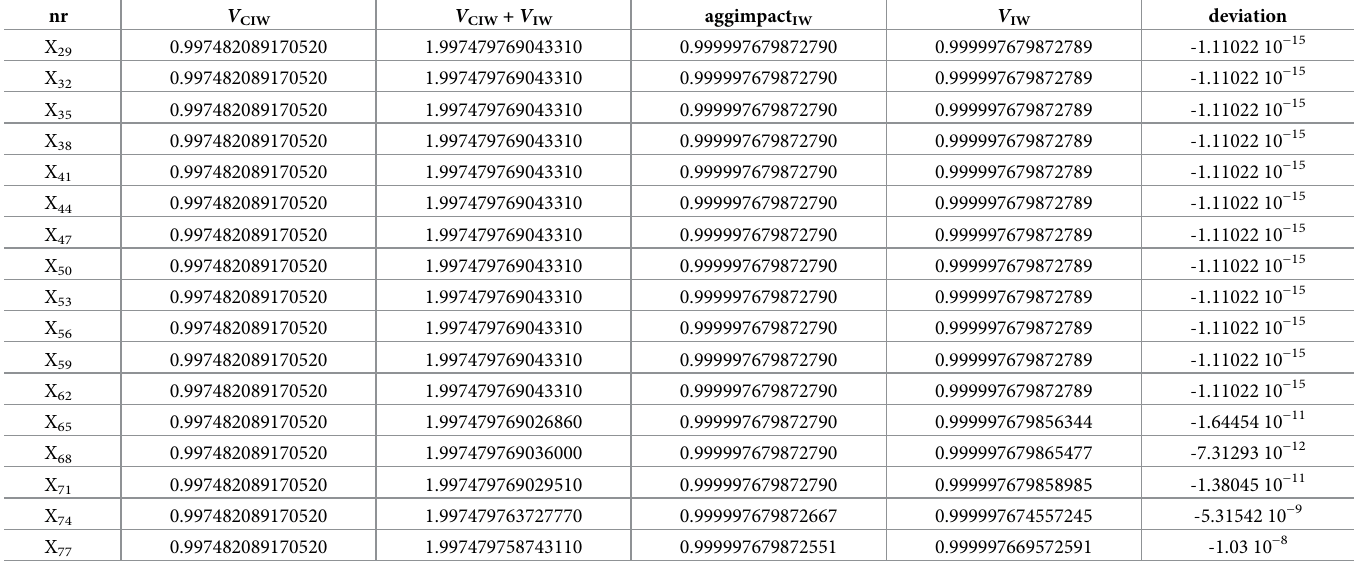
Table 7. Equilibrium analysis results for the IW-states.